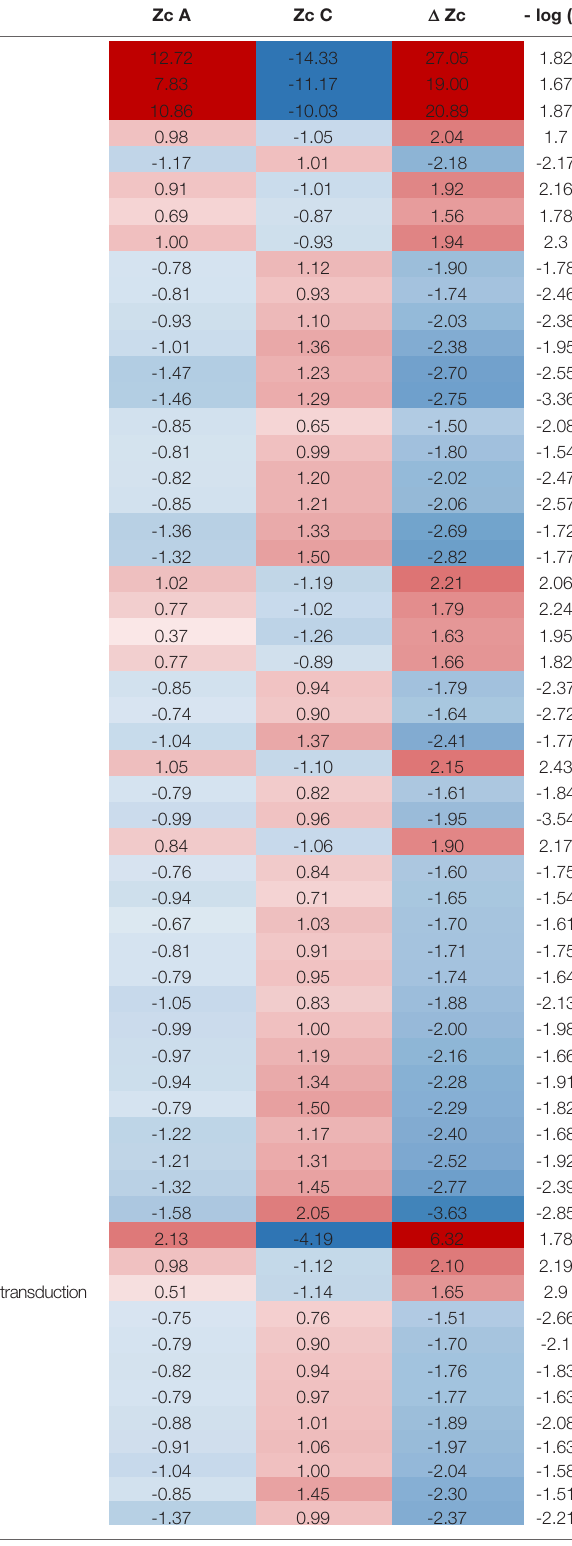
The color represents the values of abundance increase (red) or decrease (blue) grouped in functional categories (Zc) using as selection criteria (| D Zc|> 1.5) and Student ’ s t test with logarithmic transformation (|-log (p) | ≥ 1.5). Zc A, average of the Zc values in the EC-anaphylaxis group; Zc C, average of the Zc values in EC-control